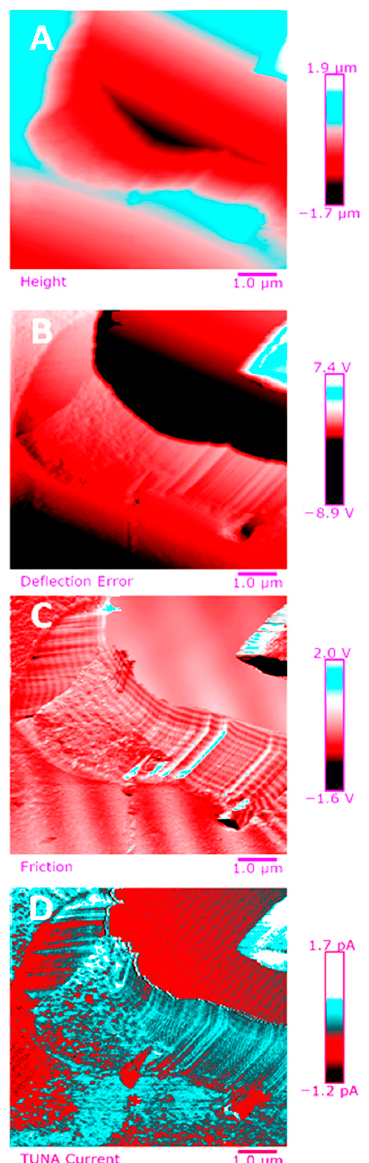
Figure 14. TUNA pictures (2D modality): ( A ) Height; ( B ) Deflection Error; ( C ) Friction; ( D ) TUNA Current of TCTBD + 0.5%MWCNT.